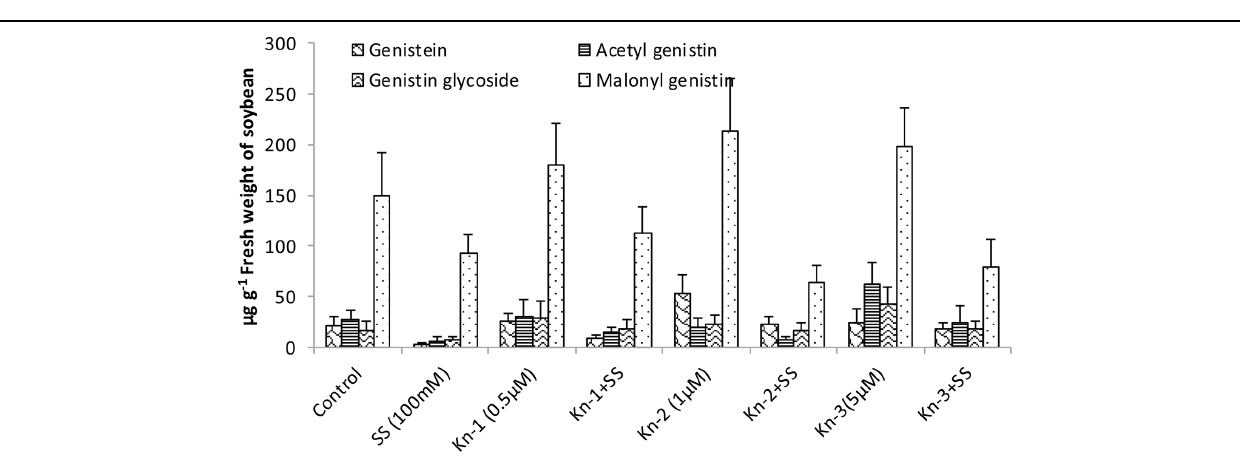
Frontiers in Plant Science |